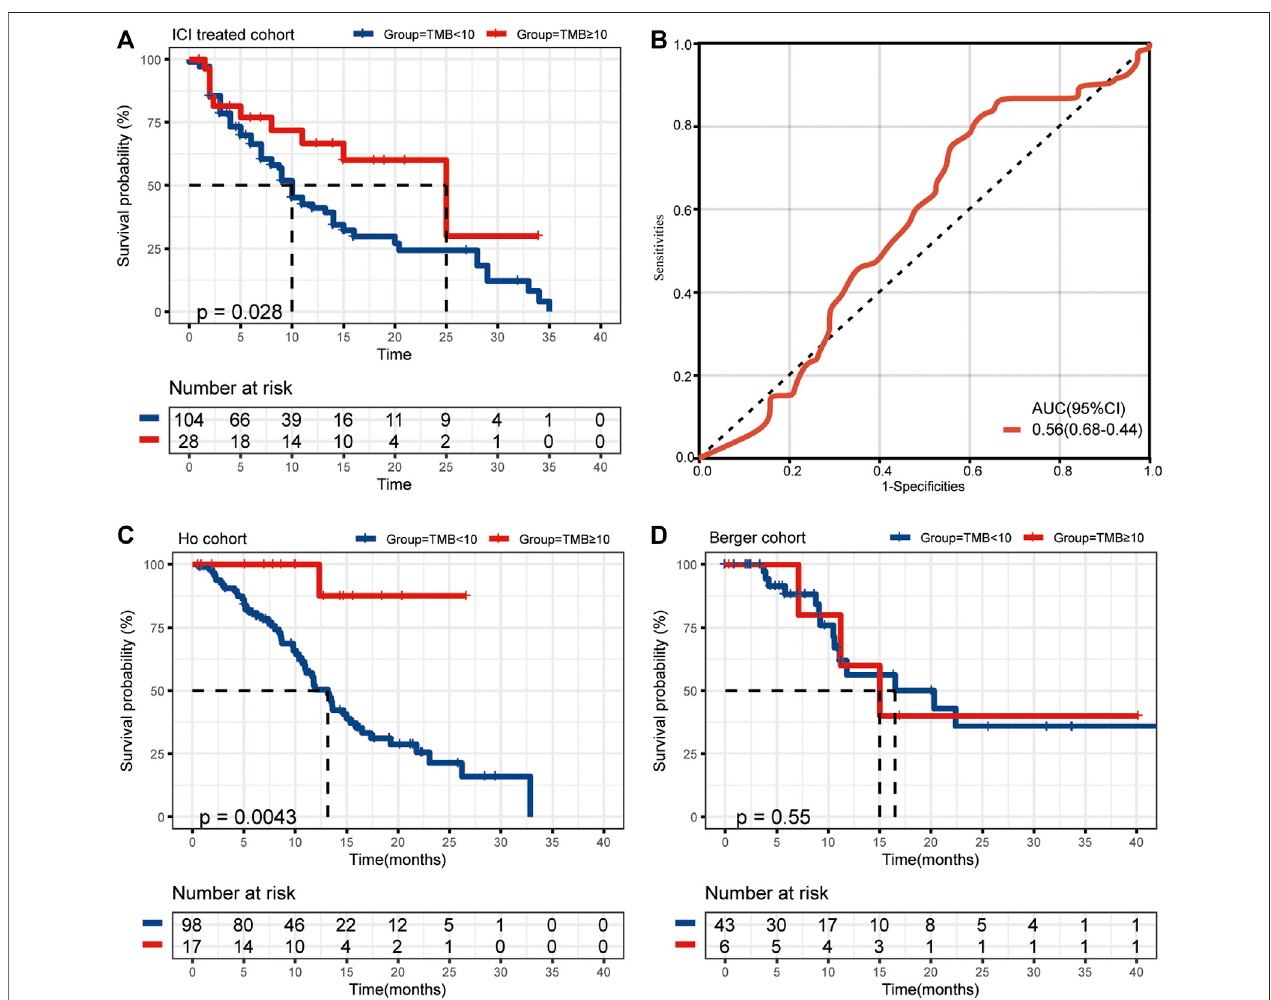
FIGURE 2| (A) The median OS ofICI-treated r/m HNSCC patients with high and low TMB (25 vs . 10 months, p (cid:1) 0.028). (B) The ROC curve ofTMB strati fi cation. (C) The difference in median OS for non-ICI-treated HNSCC patients with high and low TMB (the Ho cohort, p (cid:1) 0.0043). (D) The difference in median OS for non-ICI- treated HNSCC patients with high and lowTMB (the Berger cohort, p (cid:1) 0.55). OS, overall survival; TMB, tumor mutationalburden; ICI, immune checkpointinhibitor; r/m HNSCC, recurrent and metastatic head and neck squamous cell carcinoma; ROC, receiver operating